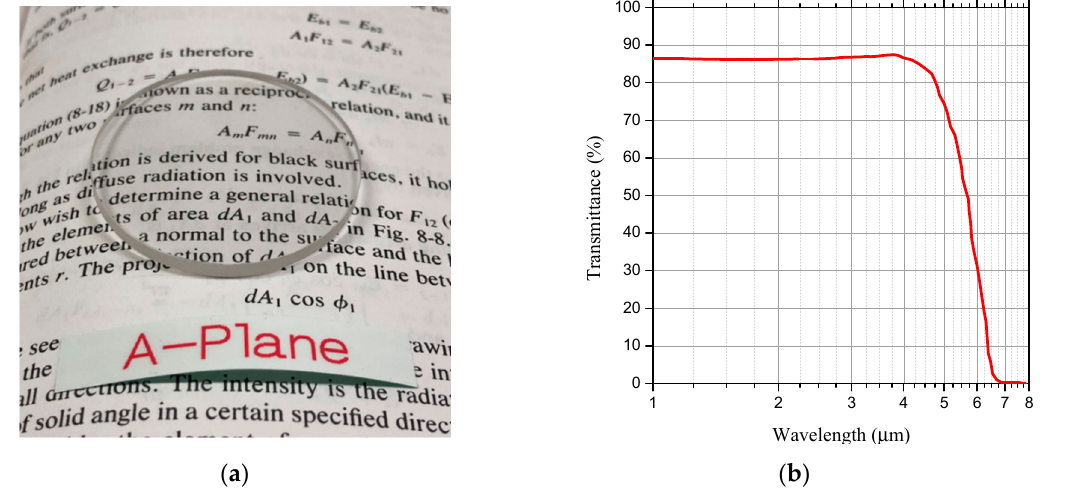
Figure 7. Characteristic of specimen for measurement. ( a ) A-plane sapphire (3 mm thick). ( b ) Transmittance curve of A-plane sapphire.